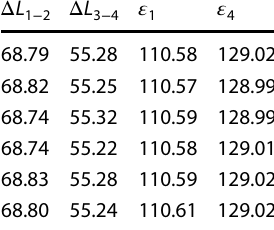
Table 2 Measurements Δ L 1 − 2 , 𝜀 1 and 𝜀 4 with six repeats Δ L 3 − 4 , for a 20 mm displacement at the centre of the plate (x = 500 mm, y = 500 mm) are shown. Δ L values are in microns and 𝜀 values are in